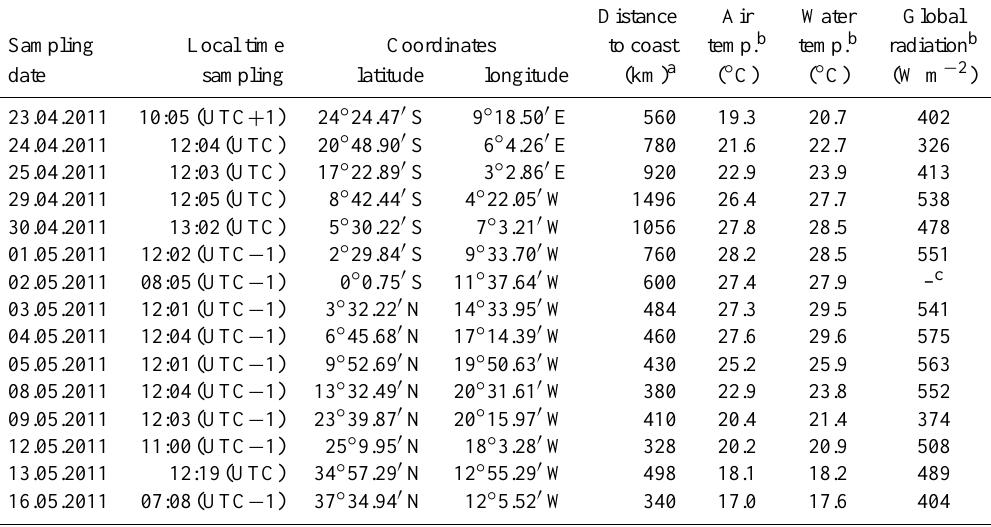
Table 1. Seawater sampling: Sampling dates and corresponding environmental parameters Distance Air Water Global Sampling Local time Coordinates to coast temp. b temp. b radiation b date sampling